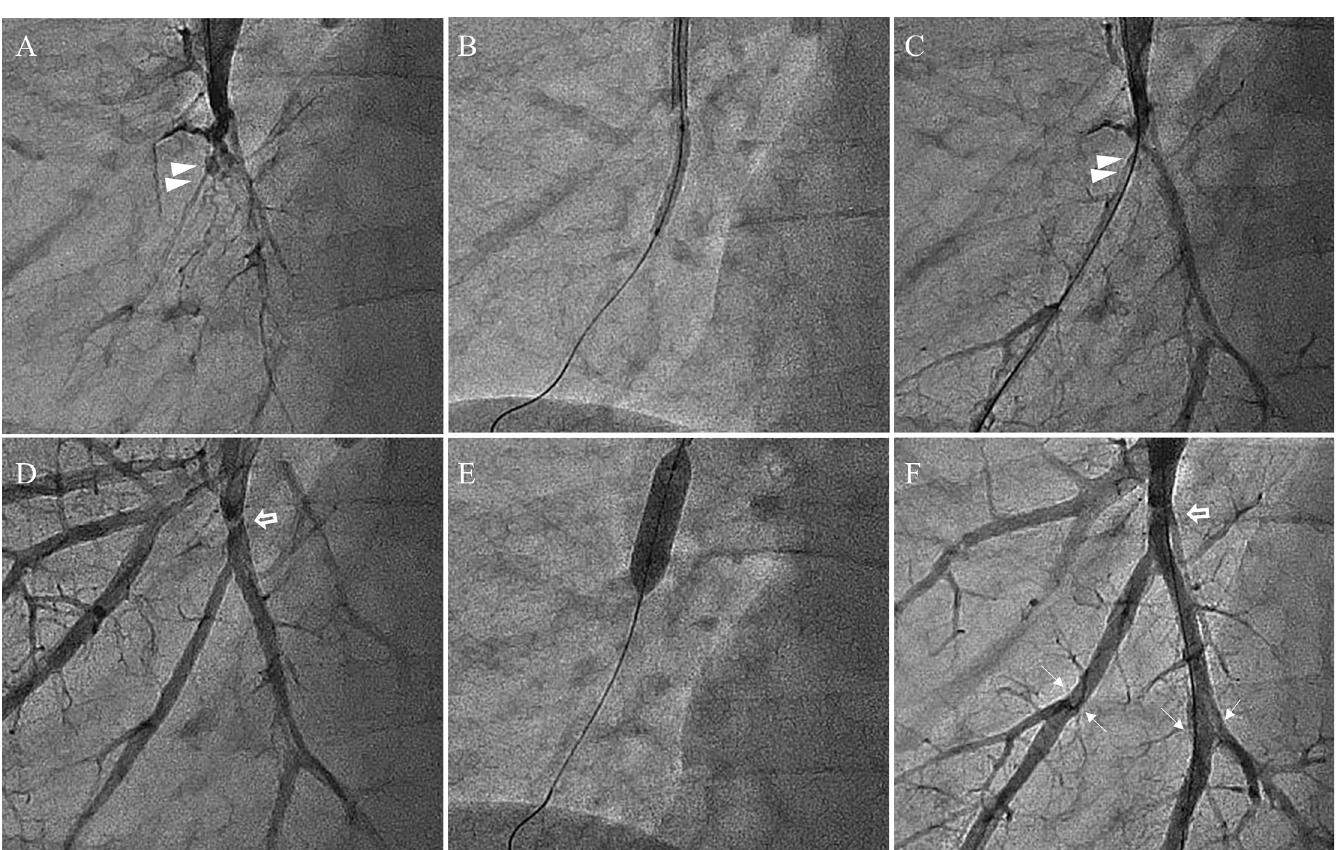
Fig 1. Balloon pulmonary angioplasty of the right pulmonary basilar artery (A10). (A) Pulmonary angiography before the first balloon pulmonary angioplasty (BPA). Subtotal occlusion (arrowhead) of the right A10. (B) The 2.0-mm balloon is dilated at 6 atmospheres in the right A10. (C) Pulmonary angiography immediately after the first BPA of the right A10 (arrowhead) shows a dilated vessel and increased flow in the distal artery. (D) Pulmonary angiography of the right A10 before BPA during the third session showing reduced pulmonary hypertension. The banded lesion (arrow) remains on the right A10. (E) The balloon size is determined visually, and the 5.5-mm balloon is dilated to 4 atmospheres. (F) Pulmonary angiography of the third BPA after overdilation of the balloon in the proximal part of the right A10 (arrow) and after dilatation of the distal bifurcation lesion (thin arrow). Extravasation of contrast media was not noted when the balloon was overdilated, and residual banded lesions can be observed (arrow). If pulmonary hypertension improved, then no major vascular injury occurred when the balloon was